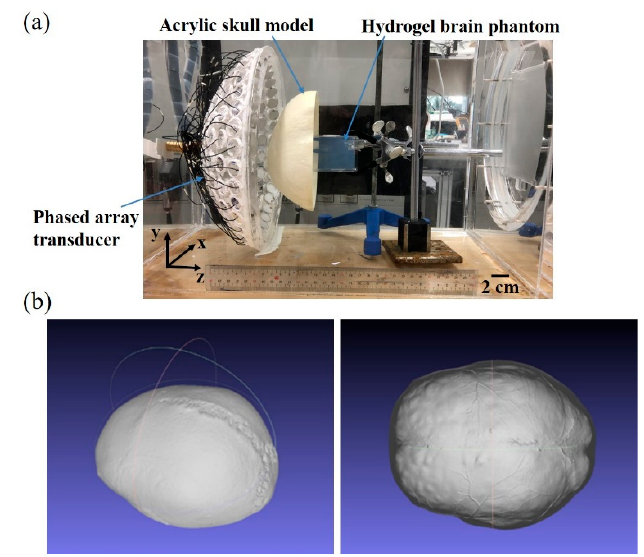
Figure 4. The experimental setup of the phantom study. The hemisphere transducer, the acrylic skull and the hydrogel phantom were aligned in the z direction ( a ). Images of the acrylic skull were taken for numerical modeling ( b ).